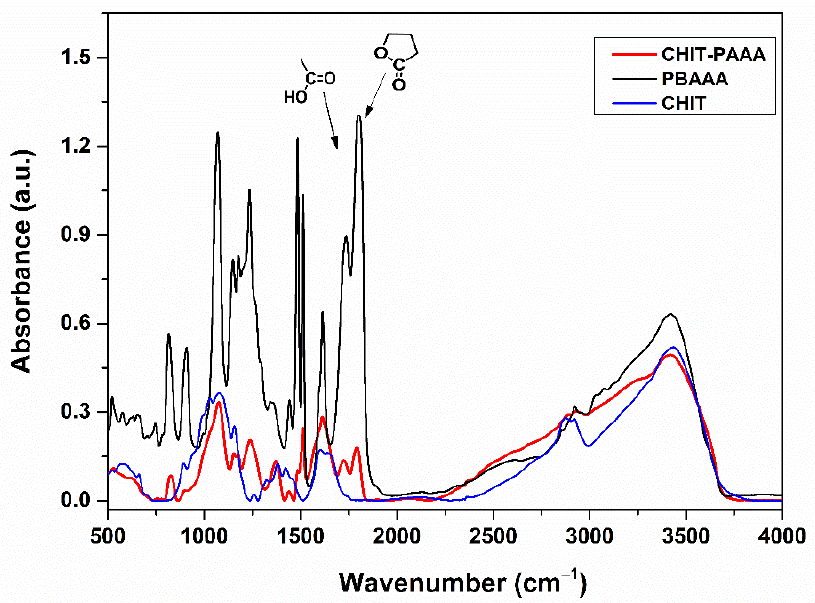
Figure 4. FTIR spectra of PBAAA (black), chitosan (blue), and copolymer CHIT-PAAA (red).